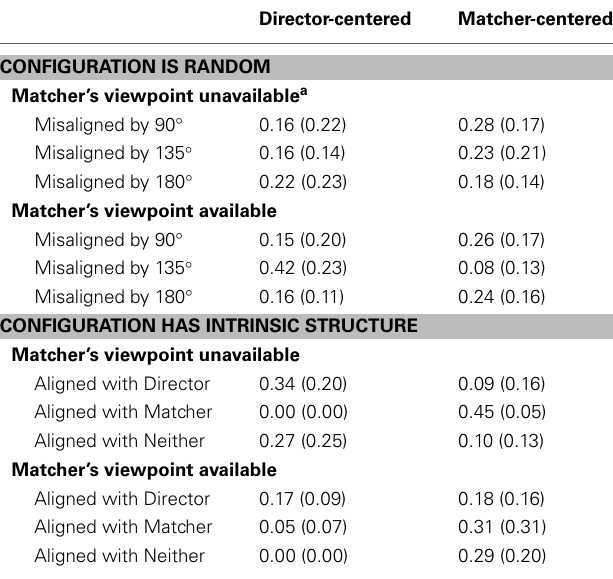
Table 1 | Means (and standard deviations) of the proportions